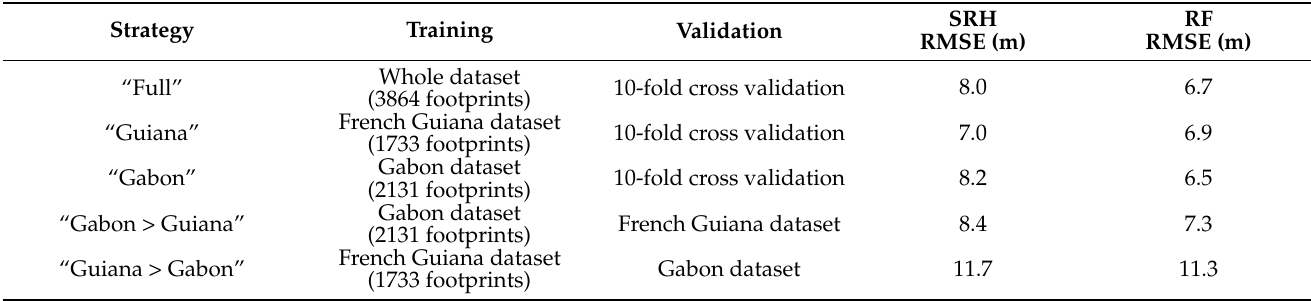
Table 5. RMSE for GEDI-CHM SRH and RF estimators depending on training/validation strategies (algorithm setting group number 5).